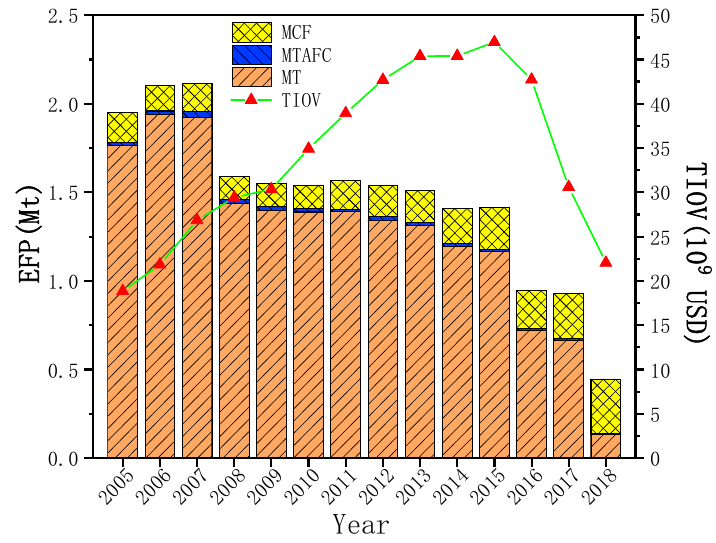
Figure 1. EFP of Shaoxing’s textile industry and the subsectors and TIOV of Shaoxing’s textile industry during 2005–2018.